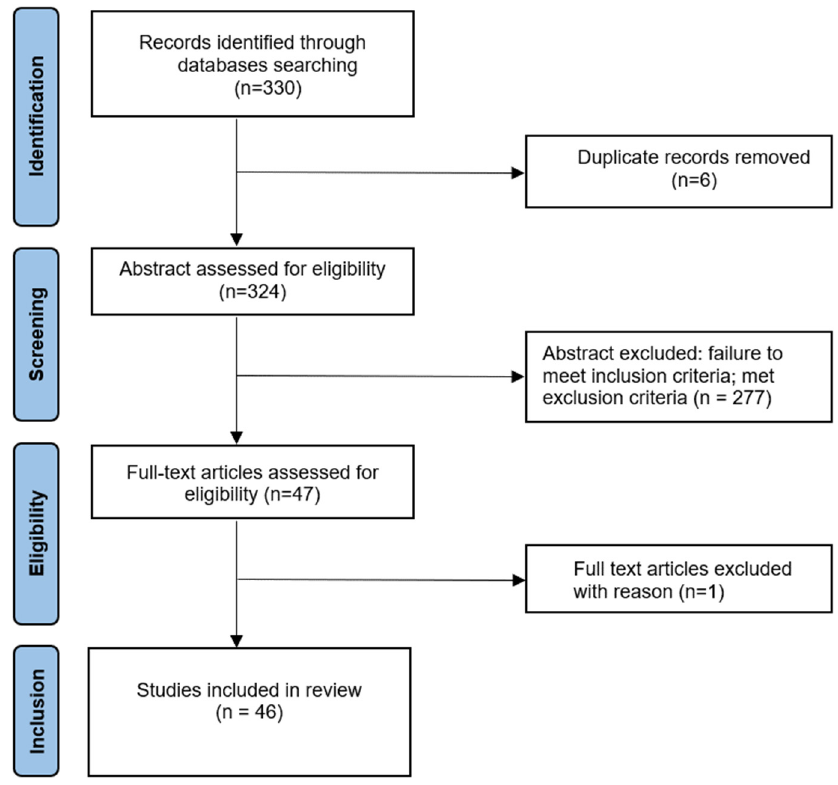
Figure 1. Flow diagram of study inclusion.